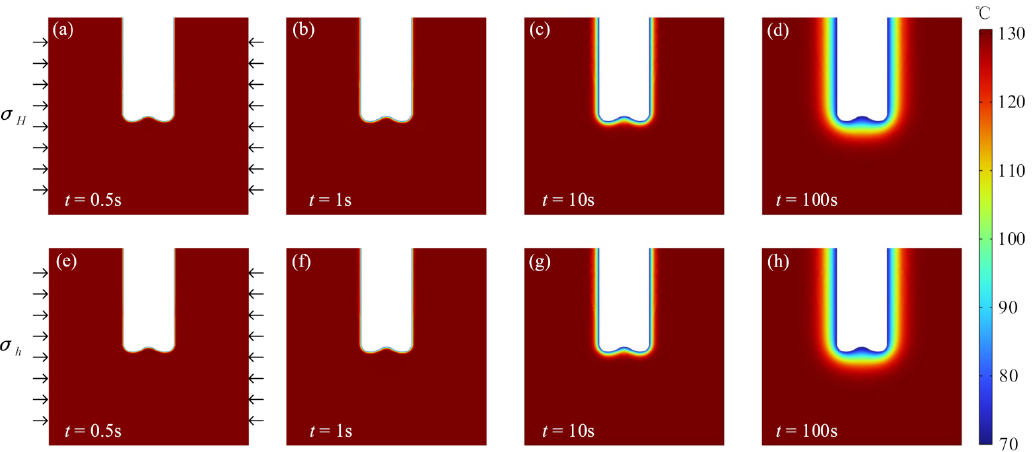
Figure 4. Formation temperature around the wellbore after drilling. ( a ) t = 0.5 s; ( b ) t = 1 s; ( c ) t = 10 s; ( d ) t = 100 s; ( e ) t = 0.5 s; ( f ) t = 1 s; ( g ) t = 10 s; ( h ) t = 100